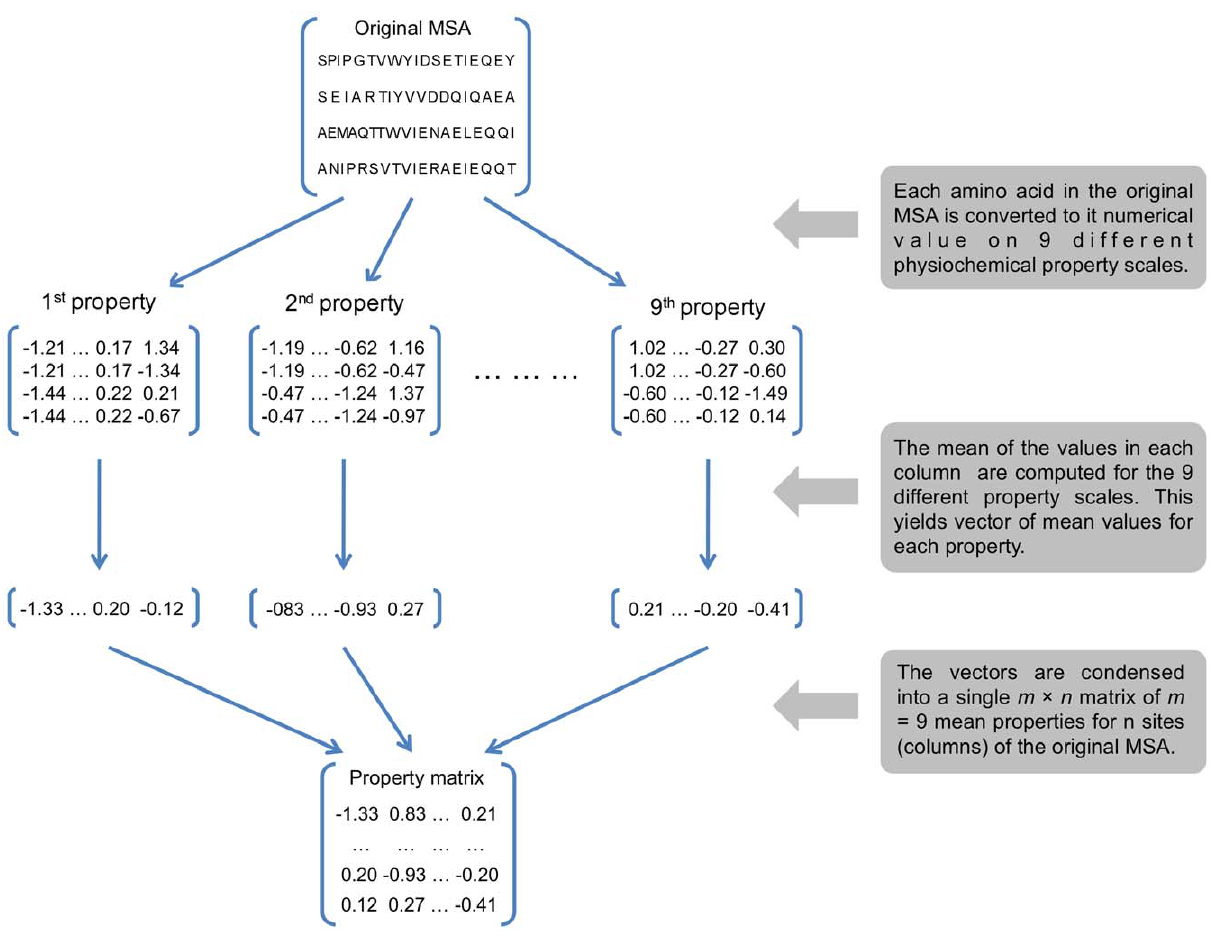
Figure 1. Schematic overview of the transformation of a matrix of sequence data to a physiochemical property matrix. The original matrix is a multi-sequence alignment (MSA) of amino acid sequences having n columns (sites). Each amino acid is converted to a numerical value on a particular physiochemical scale. To capture the complexity of the physiochemical effects, we employed m =9 different physiochemical scales in this study (see Table 1). Thus nine different transformations of the MSA were carried out. The data are then condensed into a single n 6 m matrix by computing the mean for each property at each site and constructing a column vector having m =9 different mean values for each site. Thus the final matrix has n alignment sites and m physiochemical properties.